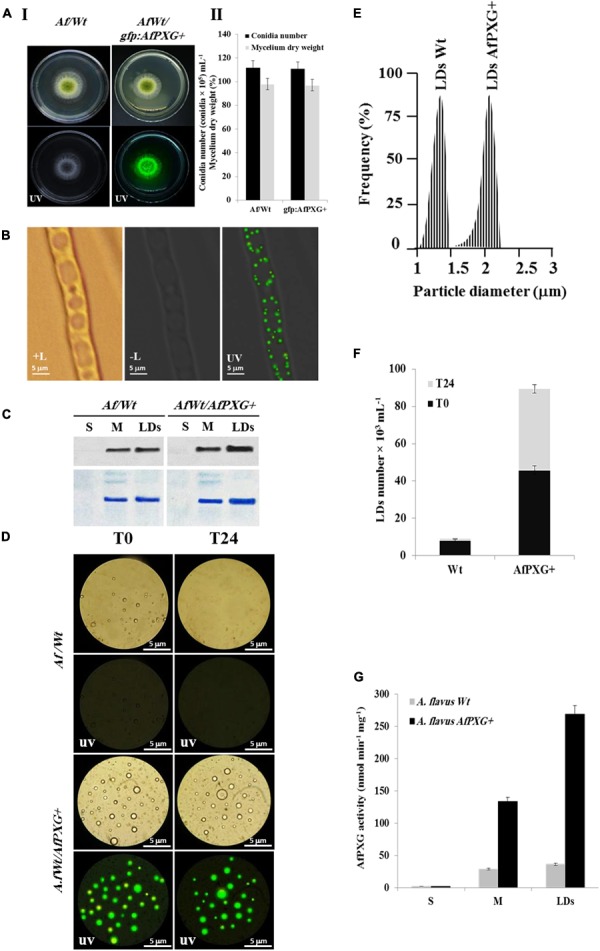
Overexpression of AfPXG is associated with increased numbers of lipid droplets (LDs) in A. flavus. (A) Growth of AfPXG-overexpressing lines compared with WT. The AfPXG gene was overexpressed under the control of AdhI promoter as described in Section “Materials and Methods.” GFP was used as a reporter gene to evaluate the efficiency of target gene overexpression. The gfp:AfPXG+ line shows fluorescence under UV similar to the WT. (B) Light and fluorescent micrographs of isolated LDs from fungal tissue of A. flavus AfPXG+ line compared with WT. Purified LDs suspended in 100 mM potassium pyrophosphate at pH 7.4 were observed under a LEICA MPS60 microscope and images viewed at a magnification of 40× immediately after preparation (T0) or 1 day later (T24). Bar represents 5 mm. (C) Immunodetection of overexpressed-AfPXG in different subcellular fractions, supernatant (S), microsomes (M), and LDs compared with their respective fractions isolated from the WT. An anti-PXG antibody was used at dilution of 1:500 in TBS buffer (pH 7.4). Horseradish peroxidase-conjugated anti-mouse IgG diluted 1:2000, served as the secondary antibody. The signal was detected in a Pharos FX molecular imager (Bio-Rad). Loading control are gels stained with Coomassie Brilliant Blue. (D–F) The purity, size, and number of LDs were evaluated by a Flow Cytometer at T0. (G) Evaluation of PXG activity (hydroxylation of aniline) in the supernatant (S), microsomes (M) and LDs from A. flavus AfPXG+ line compared with their respective fractions isolated from the WT. All measurements were done in triplicates. Results are means ± SD (n = 3).